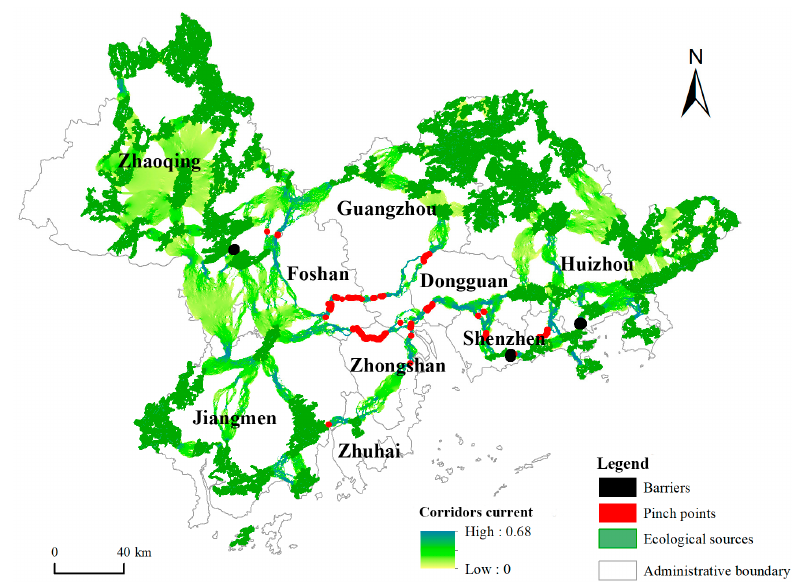
Figure 6. Ecological security patterns in the PRD region.